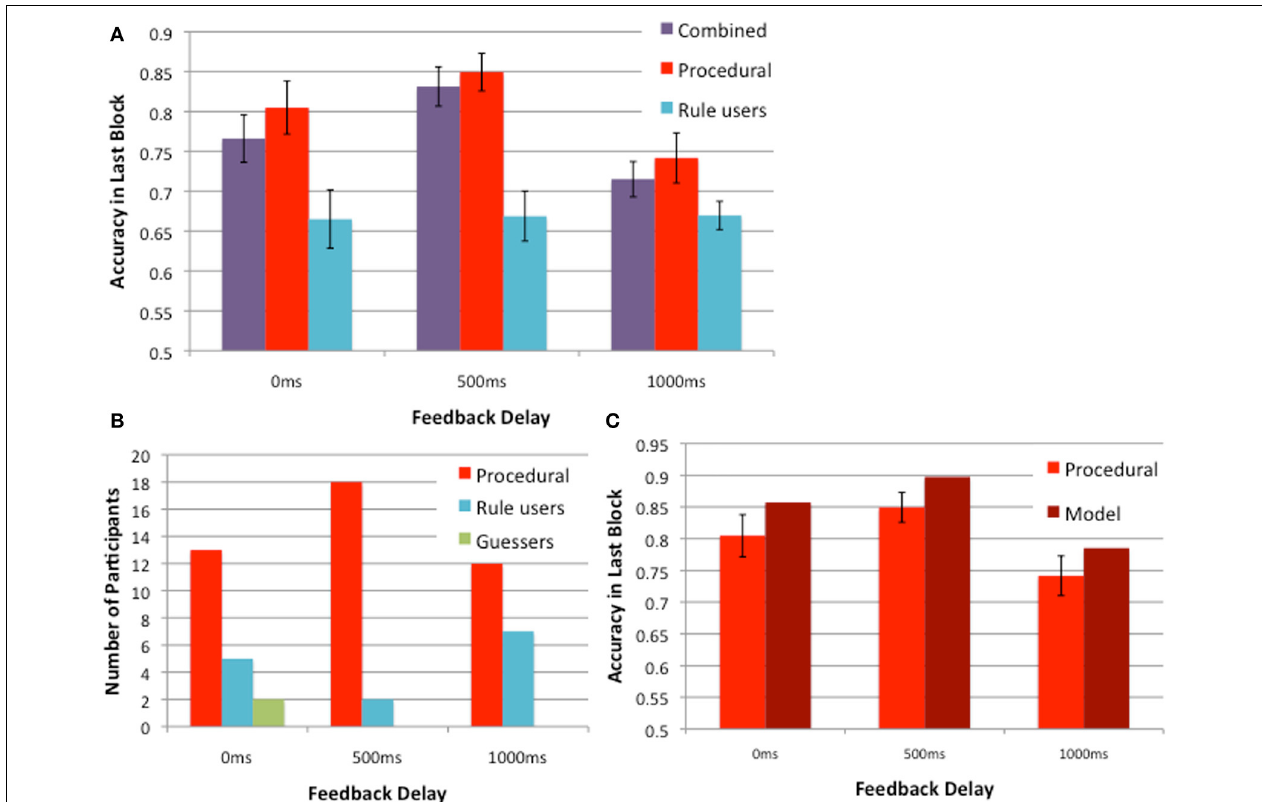
FIGURE 5 | 2013 Experiment 1 strategies: (A) feedback delay of 500ms yields better learning than that of 0 and 1000ms for a group of participants using a procedural strategy (in red), but not for those using rules (in blue). The combined accuracies for these two groups are in purple. (B) The numbers of